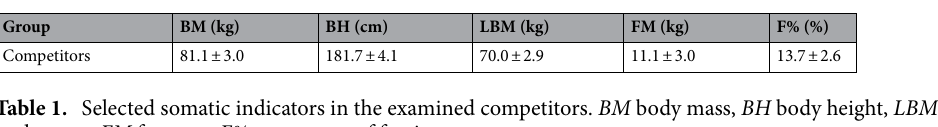
Table 1. Selected somatic indicators in the examined competitors. BM body mass, BH body height, LBM lean body mass, FM fat mass, F% percentage of fat